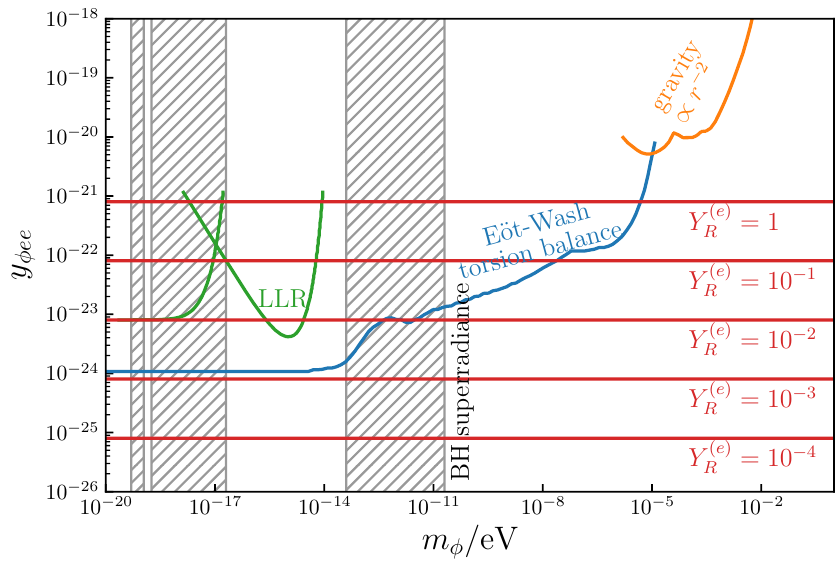
Figure 3 . The e(cid:11)ective Yukawa coupling of (cid:30) to e , compared with experimental limits. The predictions of our model (red) are evaluated according to eq. (5.2) with m ( e ) (cid:23) = 0 : 01 eV. The experimental limits come from the E(cid:127)ot-Wash torsion-balance tests of the equivalence principle (blue) [56], tests of gravitational inverse-square law (orange) [57], lunar laser-ranging (LLR, green) measurements [9, 56], and black hole superradiance (hatched bands)